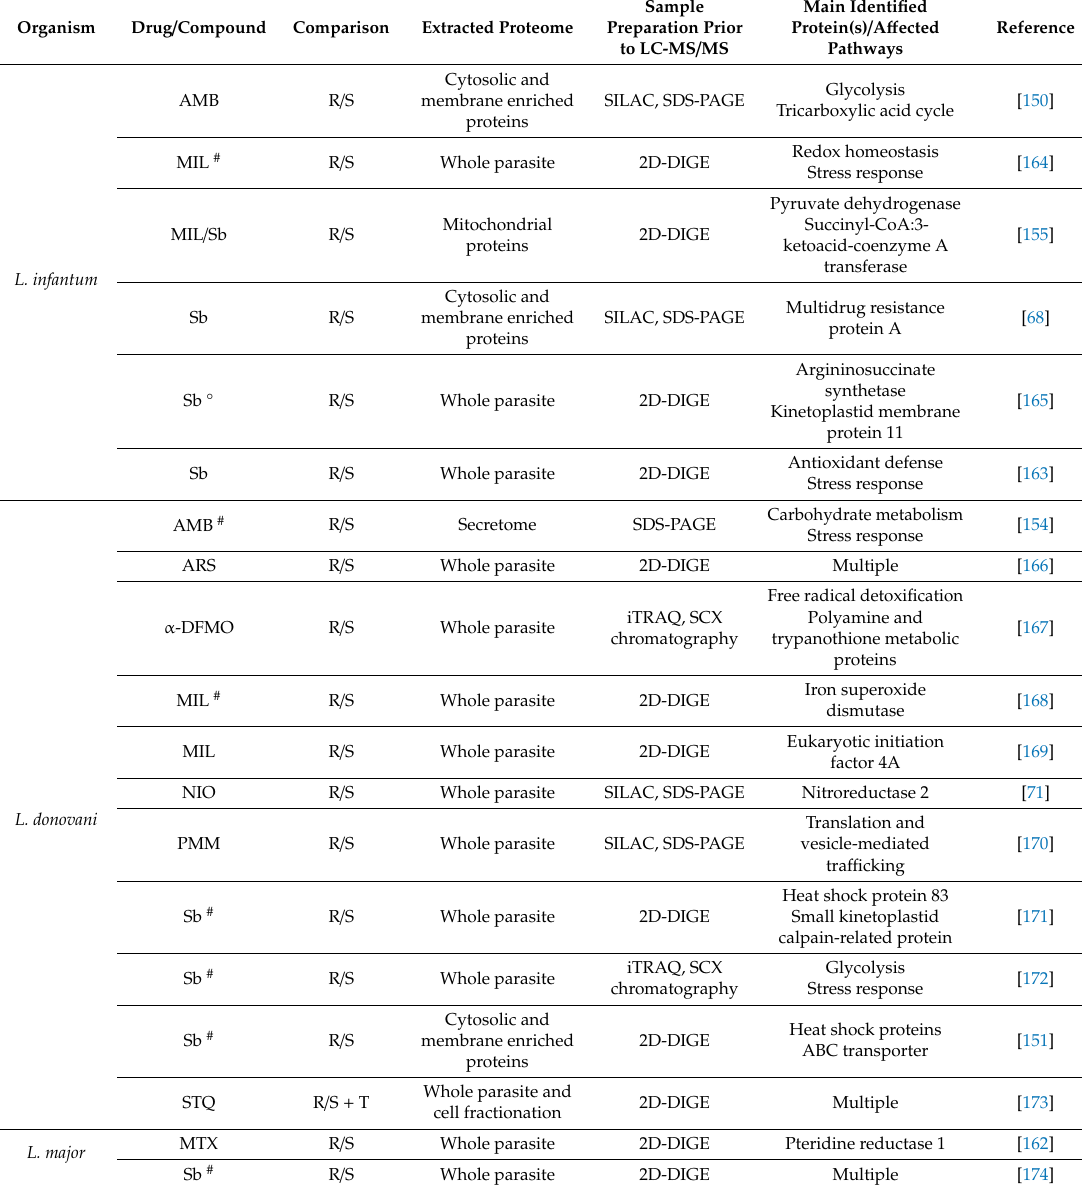
Table 4. Use of untargeted proteomics to unravel the MoA or MoR of anti-kinetoplastid drugs. Experiments with Leishmania spp. and T. cruzi were performed on promastigotes and epimastigotes, respectively. T / UT: comparison between treated and untreated parasites. R / S: comparison between resistant and susceptible